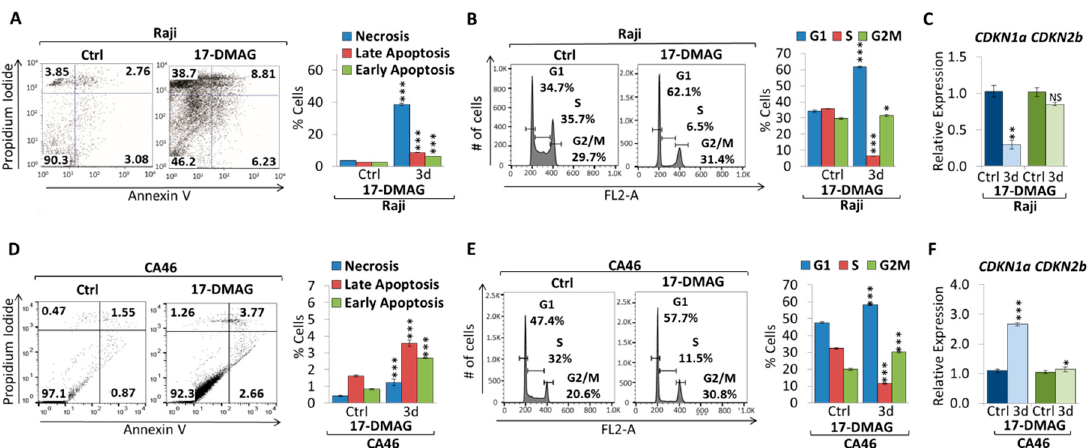
Figure 4. 17-DMAG treatment causes apoptosis and cell cycle arrest in Burkitt lymphoma. Flow cytometric analysis of apoptosis using AnnexinV/PI staining. Flow cytometry profile of AnnexinV staining (X axis) and PI (Y axis) is shown for ( A ) Raji and ( D ) CA46 cell lines upon three days treatment with 1 µ M 17-DMAG compared to untreated control. The lower right quadrant indicates the percentage of early apoptotic cells in each condition; the upper right quadrant indicates the percentage of late apoptotic cells; the upper left quadrant indicates percentage of necrotic cells; and the left lower quadrant indicates percentage of live/non-apoptotic cells. Apoptotic cells (Annexin V-positive cells) are displayed as the percentage of gated cells. Flow cytometric cell cycle analysis using propidium iodide (PI) staining in ( B ) Raji and ( E ) CA46 cell lines upon three days treatment with 1 µ M 17-DMAG compared to untreated control. Cell cycle distribution (G1, S and G2/M) are displayed in percent. RT-qPCR of CDKN1a and CDKN2b upon three days treatment of 1 µ M 17-DMAG compared to untreated control in ( C ) Raji and ( F ) CA46 cell lines. RT-qPCR was normalized to RPL13a. Error bars represent mean ± SEM; n = 3; two-tailed Student’s t -test: NS = not significant; * p < 0.05; ** p < 0.01; *** p < 0.001.